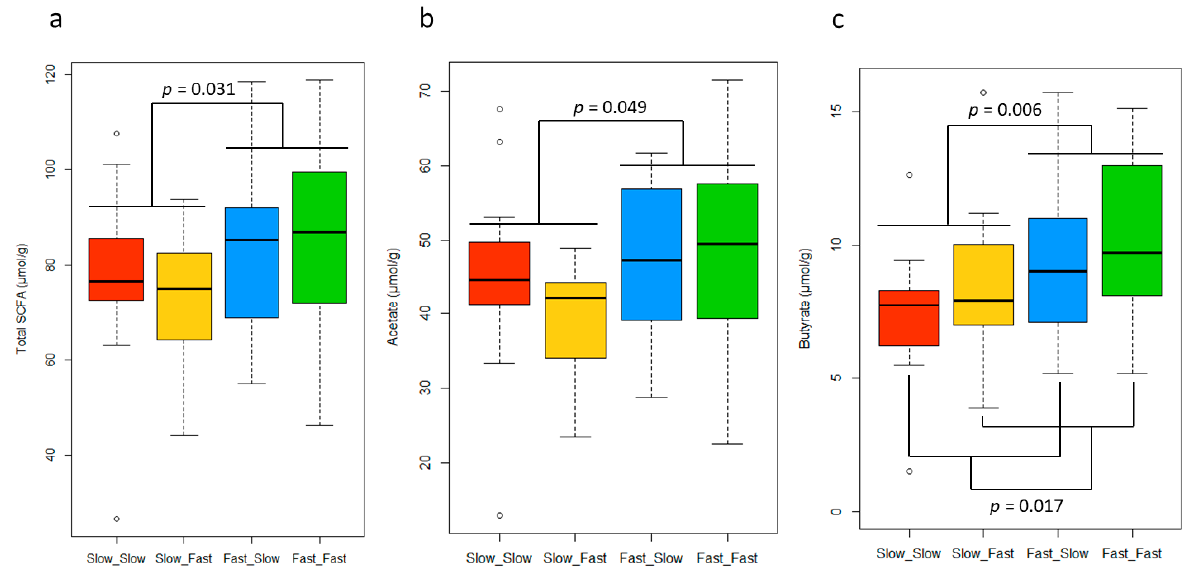
Figure 4. Boxplot representing the total short-chain fatty acid (SCFA) ( a ), acetate ( b ), and butyrate ( c ) concentrations in feces for each group. The p -values correspond to the factorial ANOVA. ast_Fast: pigs showing fast growth during the lactation and nursery periods ( n = 18, missing samples = 1), Fast_Slow: pigs showing fast growth during the lactation period and slow growth during the nursery period ( n = 18, missing samples = 1), Slow_Fast: pigs showing slow growth during the lactation period and fast growth during the nursery period ( n = 16, missing samples = 3), and Slow_Slow: pigs showing slow growth during the lactation and nursery periods ( n = 17, missing samples = 1).